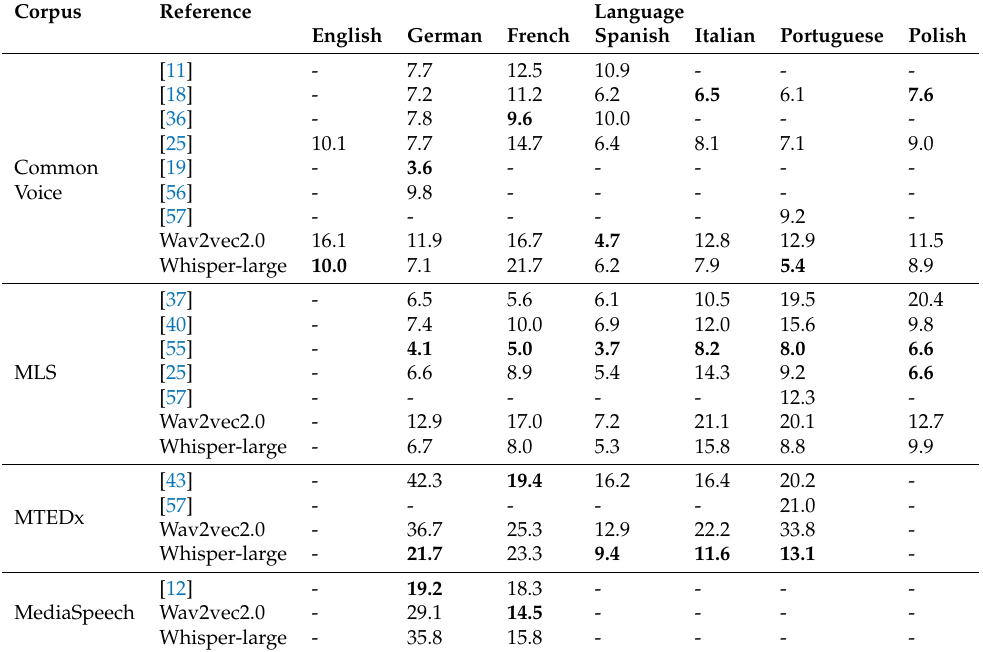
Table 4. WER comparison between the results reported and those from the state-of-the-art for Com- mon Voice, MLS, and MTEDx corpora. The best result for each corpus and language is highlighted in